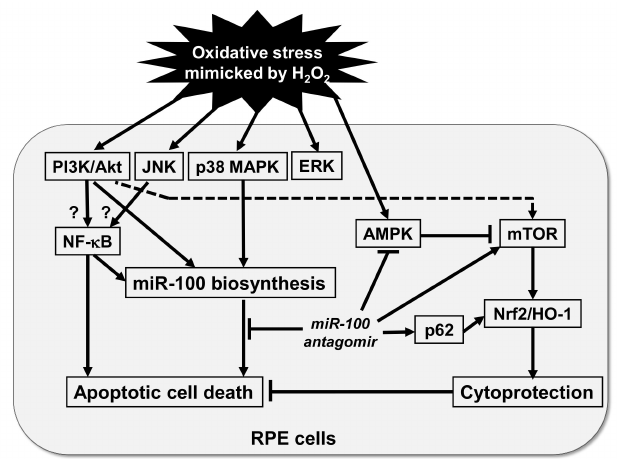
Figure 8. A hypothetical scheme showing the network of oxidative-stress-induced signal pathways, miR-100 biosynthesis, and their roles in the oxidative cell death of retinal pigment epithelial (RPE) cells. The study findings demonstrated that hydrogen peroxide (H 2 O 2 )-mimicked oxidative stress may activate signaling pathways including the hyperphosphorylation of Akt, JNK, p38 MAPK, ERK, and NF- κ B. The mediator activities of PI3K/Akt, p38 MAPK, and NF- κ B contribute to endogenous miR-100 expression, thereby leading to apoptotic cell death. The NF- κ B signal mediator very likely lies downstream of the Akt and JNK axes, which awaits further elucidation. The PI3K/Akt/mTOR axis is known to mediate cell survival signals. Mechanistically, miR-100 antagomir treatment not only attenuates oxidative stress-related AMPK phosphorylation but also restores cellular mTOR and p62 levels and upregulates antioxidant heme oxygenase-1 (HO-1) expression, thereby protecting RPE cells against oxidative cell death. Arrows, stimulatory; T lines, inhibitory; Solid lines, new findings of this study; Dashed line, previously identified mechanism; Question marks, unknown